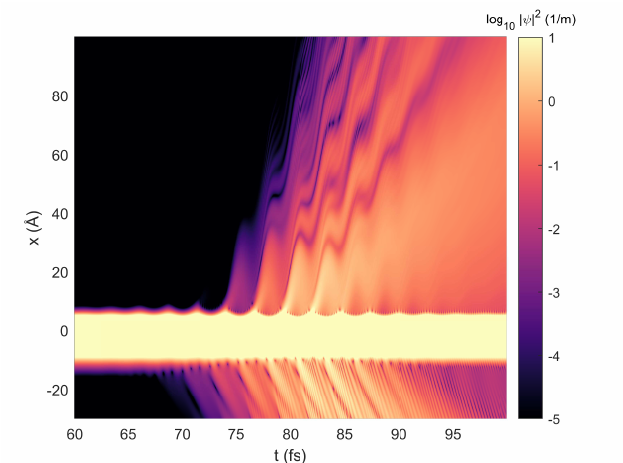
Figure 5. A focused view of the electron probability density in space over time. The electron begins at its ground state in the metal towards the left. As the external field is applied, the electron may be excited and/or tunnel out of the metal. Once outside the metal, it may propagate and either return to the metal or escape permanently. Various energy bands may be seen just from this image from the different slopes of electron probability density bunches. This simulation was performed using a 20 GV/m peak enhanced field at 800 nm. Note that the snippet shown here is only a piece of the full simulation—neither spatial nor temporal boundaries are